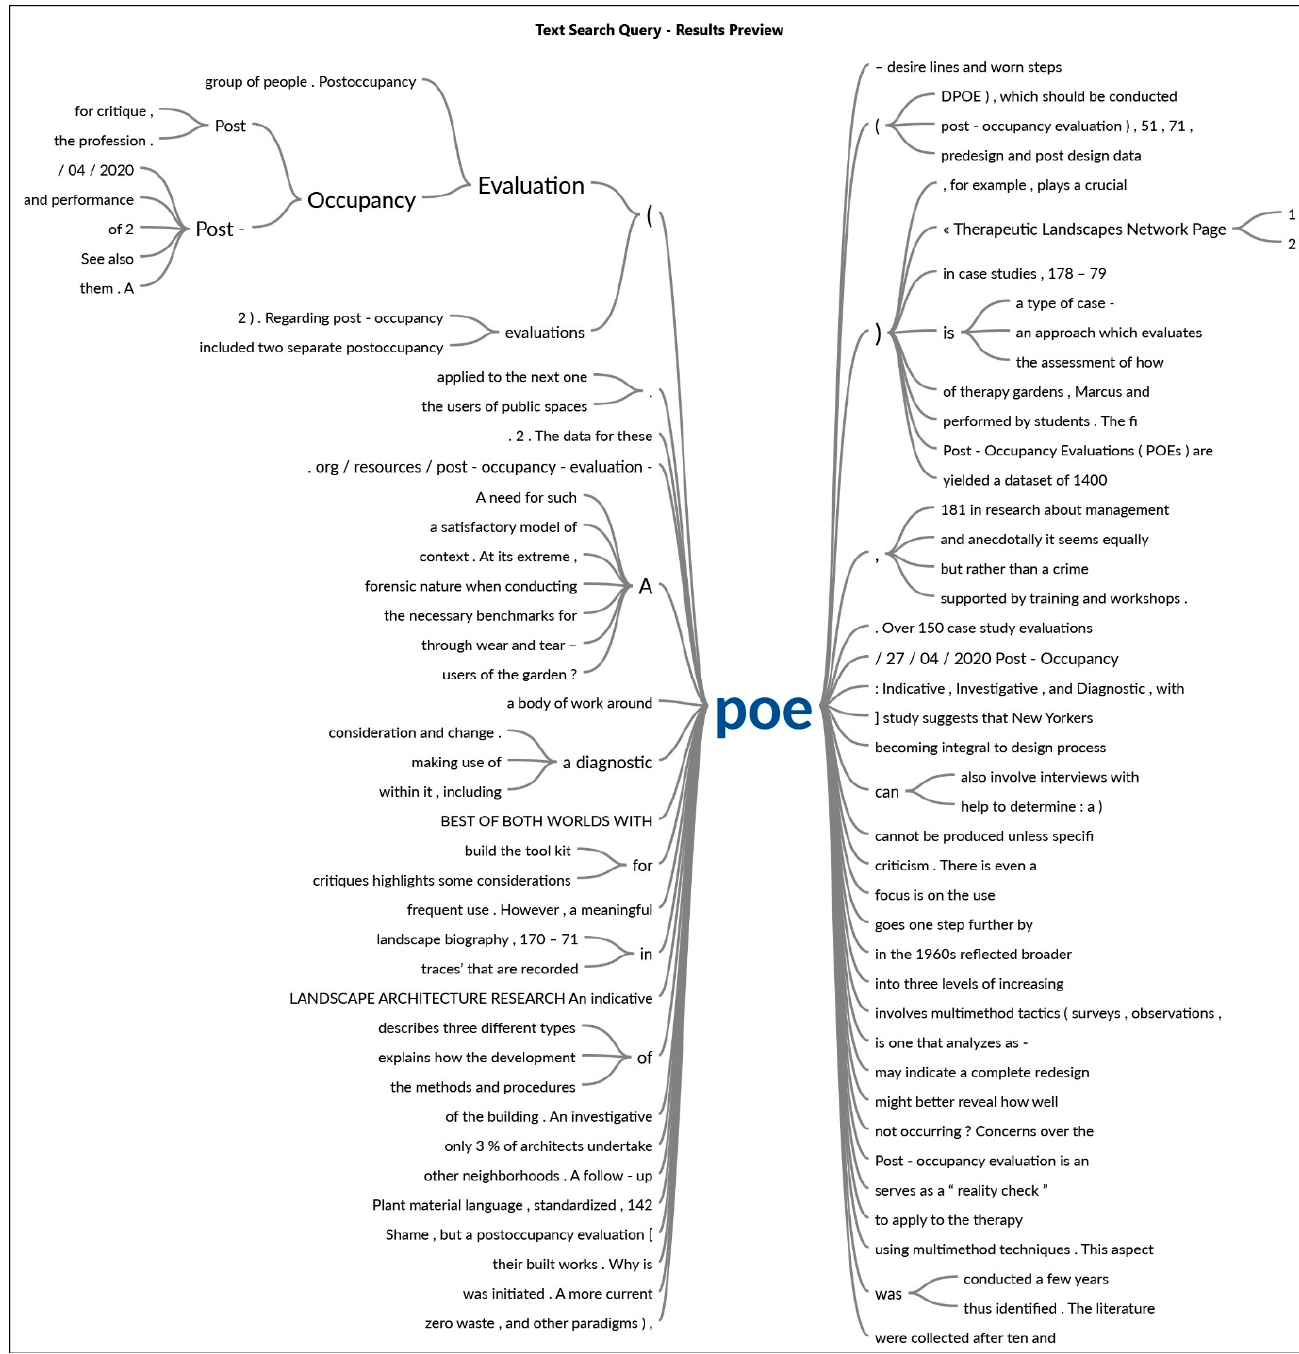
Figure 2. An example “word tree” exported from NVIVO.